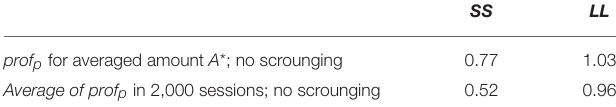
TABLE 4 | Profitability ( simulation 2